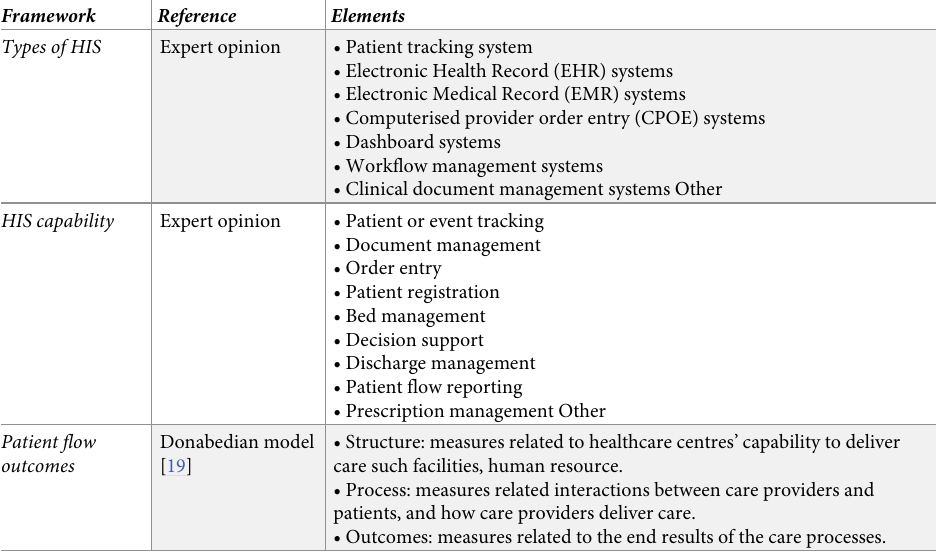
Table 3. Analytic frameworks of health information